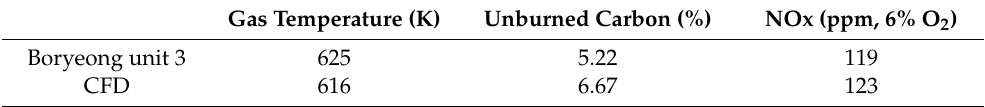
Table 4. Comparison of actual and predicted values at the boiler